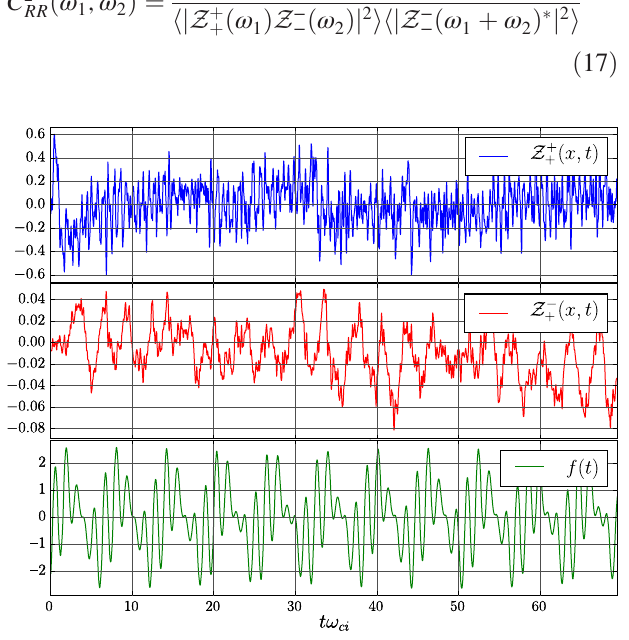
FIG. 8. Temporal evolution of right-handed Z þ left-handed Z − ð x; t Þ (middle) fluctuations, as well as the syn- þ thetic fiducial signal (bottom; see text) over one of the 100 windows (run